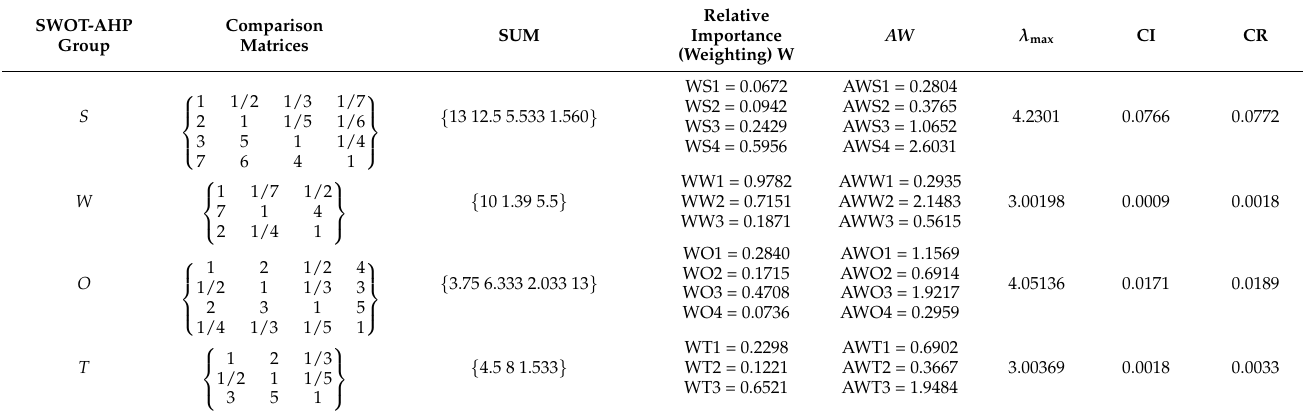
Table 9. The details about the SWOT-AHP model.